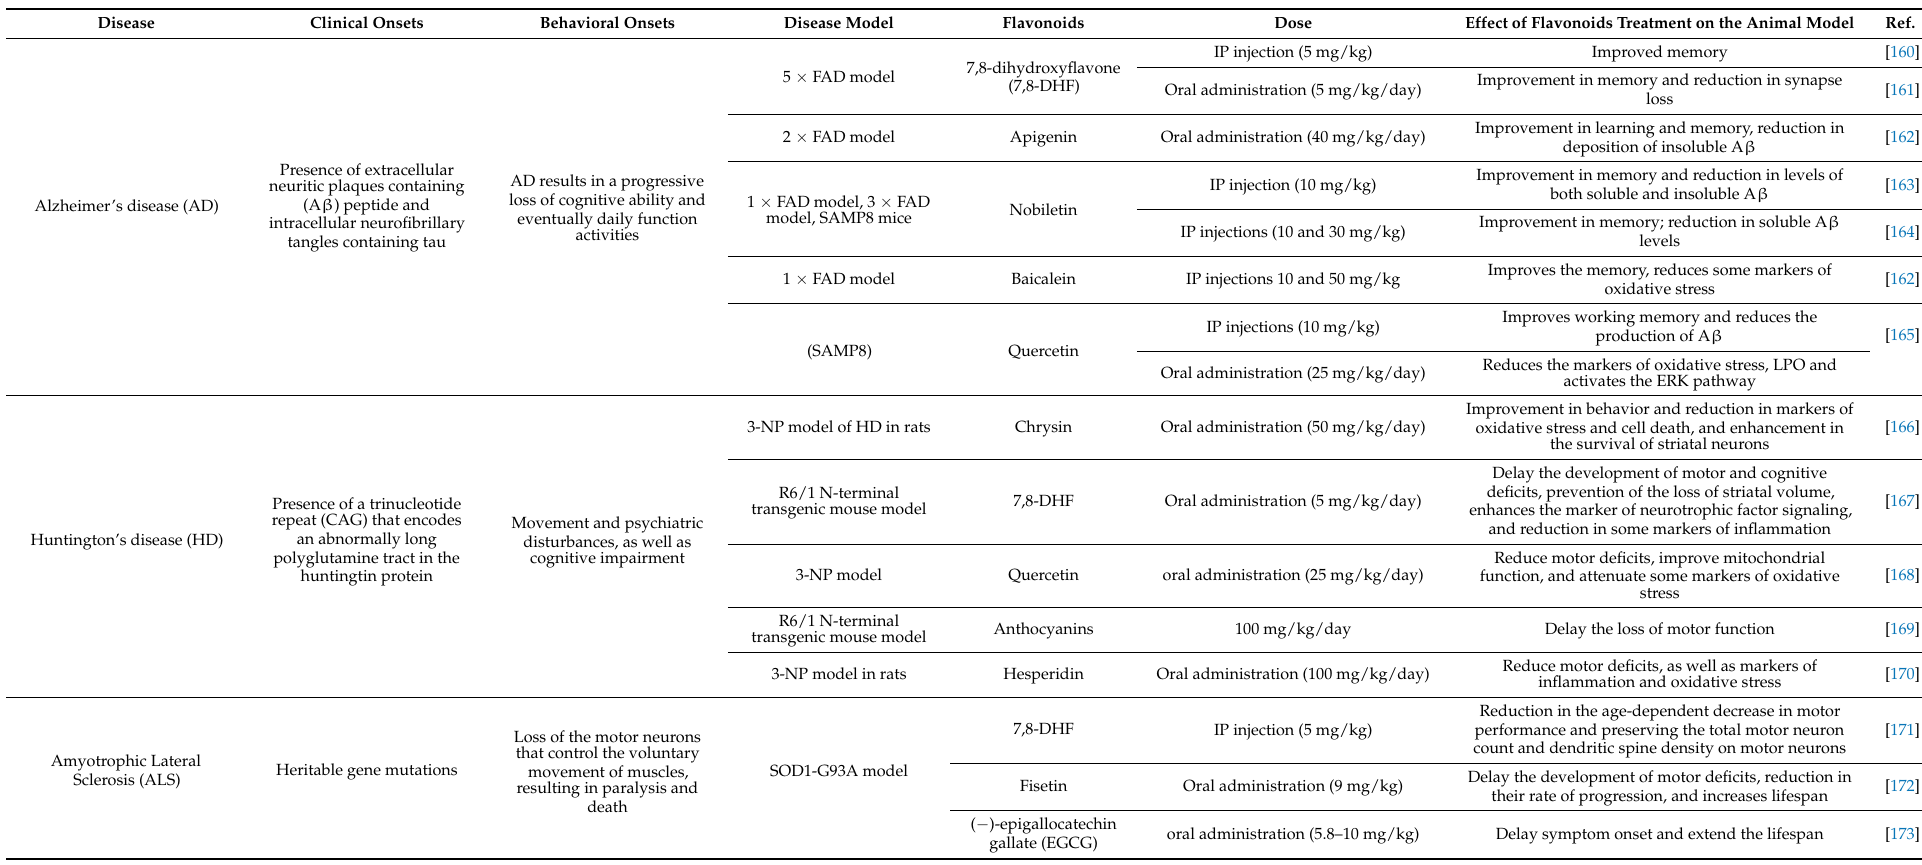
Table 3. Studies related to the effect of flavonoids on the animal